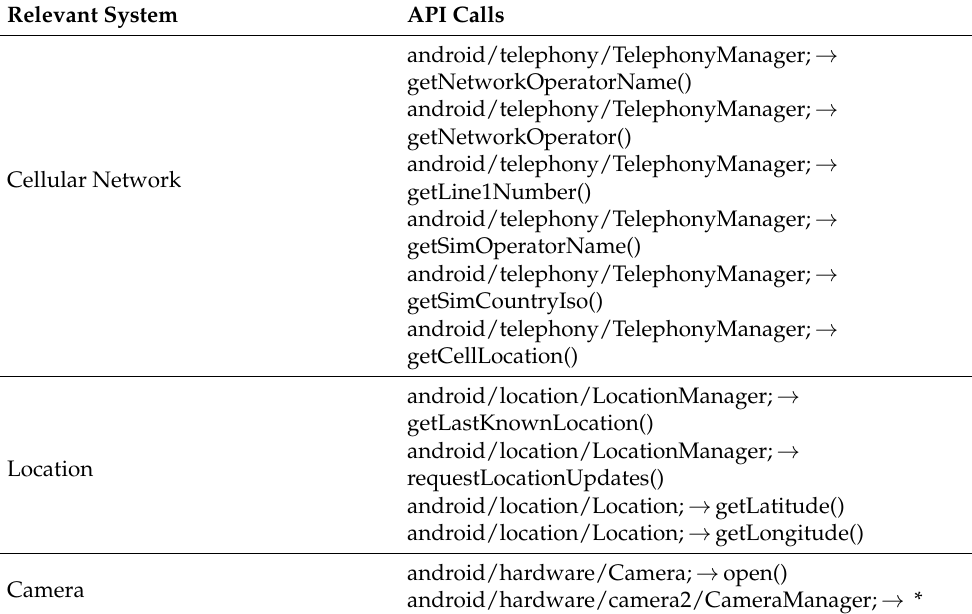
Table 3. Categorisation of sensitive API calls discovered in the apps. * All class